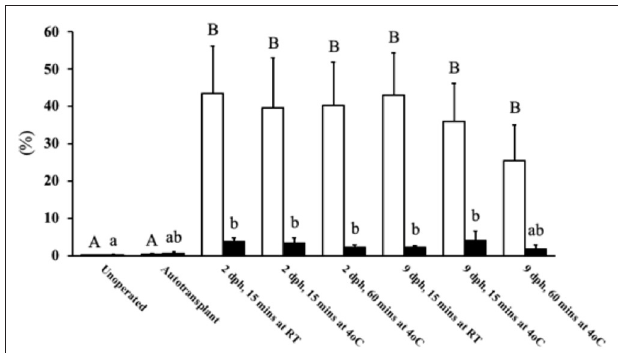
FIGURE 1 | T and B cell levels within transplants from Study 1. After 6 days post-surgery, there were high levels of T cells within the transplants for all treatment groups compared to the unoperated and autotransplant groups; there was also an increase in B cells but not to the same degree. The open bars show the percent of CD3 immunostained cytoplasm within the transplants, used to estimate the amount of T cells; whereas the solid black bars show the percent of PAX5 immunostained nuclei used to estimate the number of B cells. Tissue was collected from unoperated control birds at 8 dph. For the autotransplants and allotransplants, the tissue was collected at 6 days post-surgery (8 dph). There was no difference in T and B cell levels within the allotransplants based on donor age (2 vs. 9 dph), the time the tissue spent in holding media (15 vs. 60 mins), or the temperature of the media (RT vs. 4 ◦ C). Data are means ± SEM of n = 5 . Statisitcs: one-way ANOVA followed by a post-hoc , P ≤ 0.05. A,B means for percent of CD3 with no common superscript differ significantly. a,b Means for percent of PAX5 with no common superscript differ significantly. dph, days posthatch; RT, room